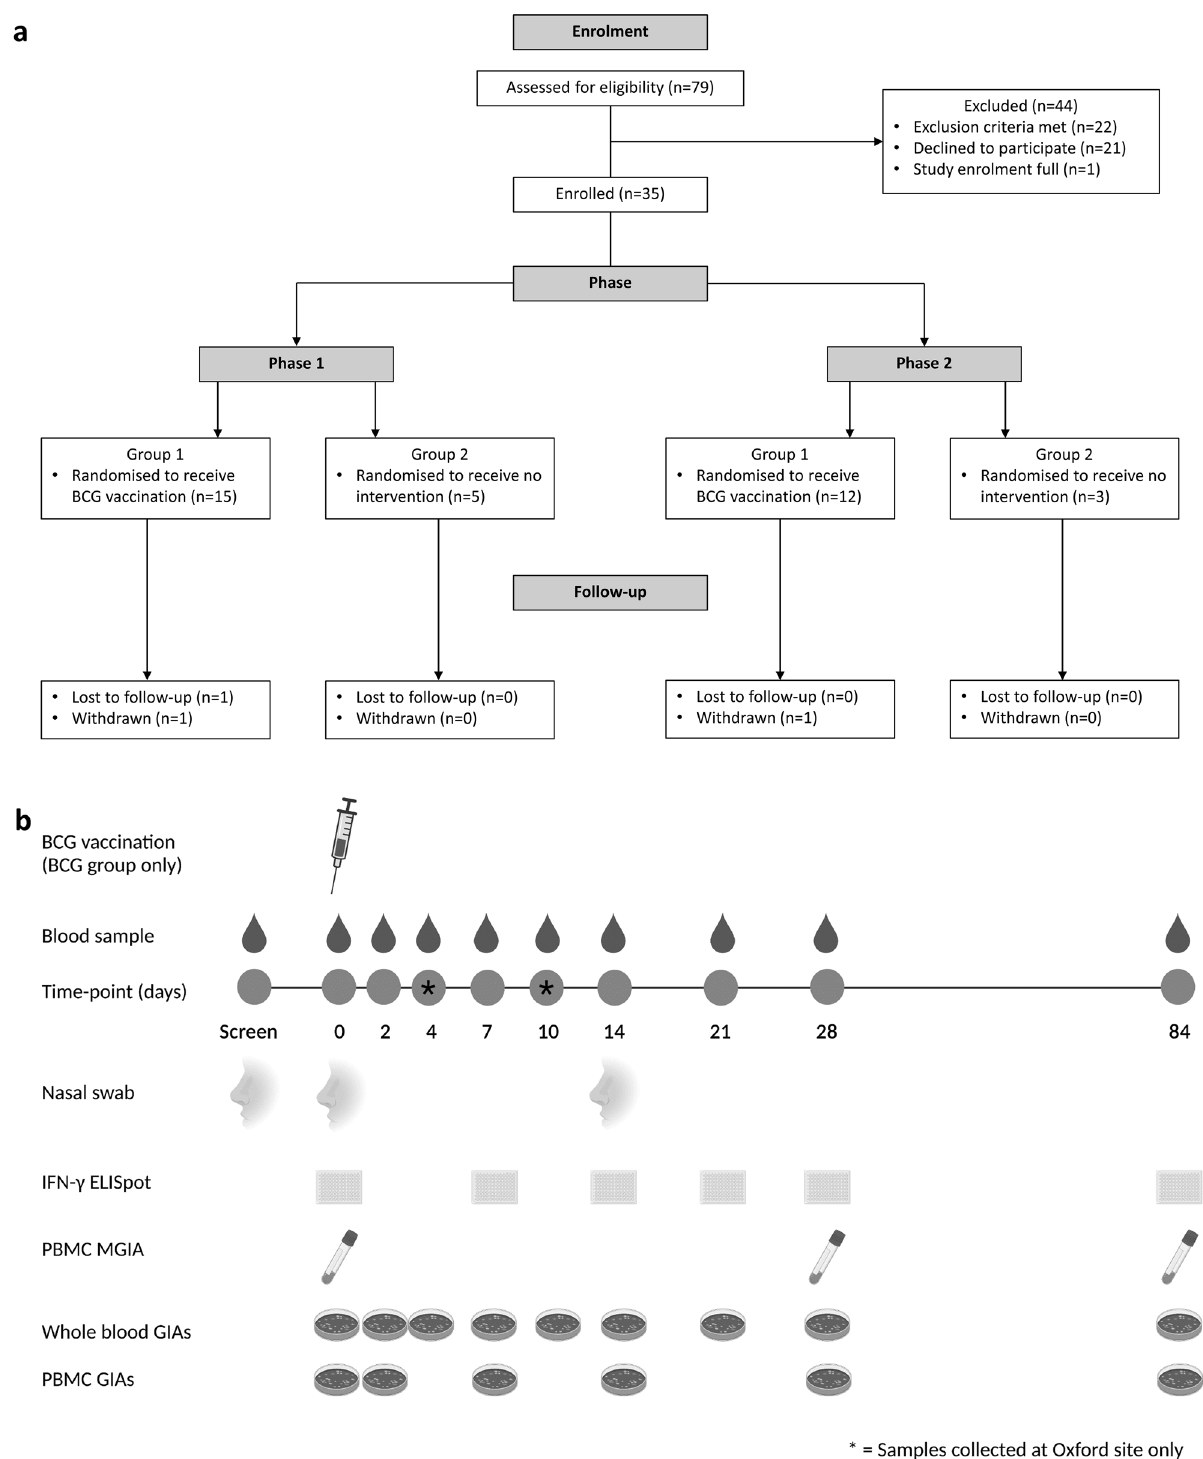
Figure 1. Consort diagram of volunteer recruitment and study schedule. Volunteers (see Table 1 for demographics) were enrolled in two phases and randomised to receive either BCG vaccination or no intervention ( a ). Volunteers had blood samples collected at screening and days 0 (baseline), 2, 4, 7, 10, 14, 21, 28 and 84. Volunteers from Birmingham followed the same schedule with the exception of follow-up visits on days 4 and 10 which were omitted for logistical reasons. Nasal swabs for determination of S. aureus carriage status were taken at screening and days 0 and 14 ( b